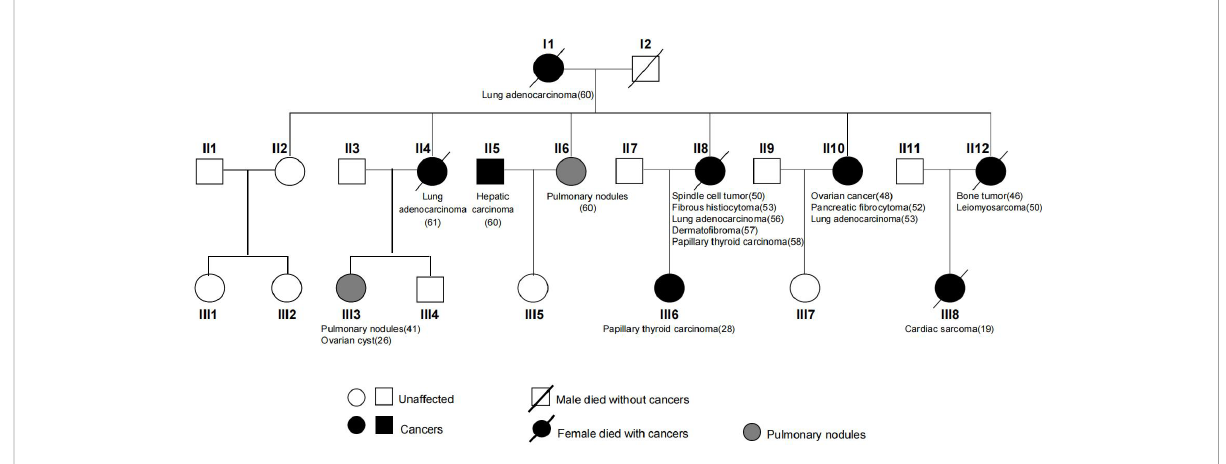
FIGURE 1 Pedigree of the LFL family across three generations in this